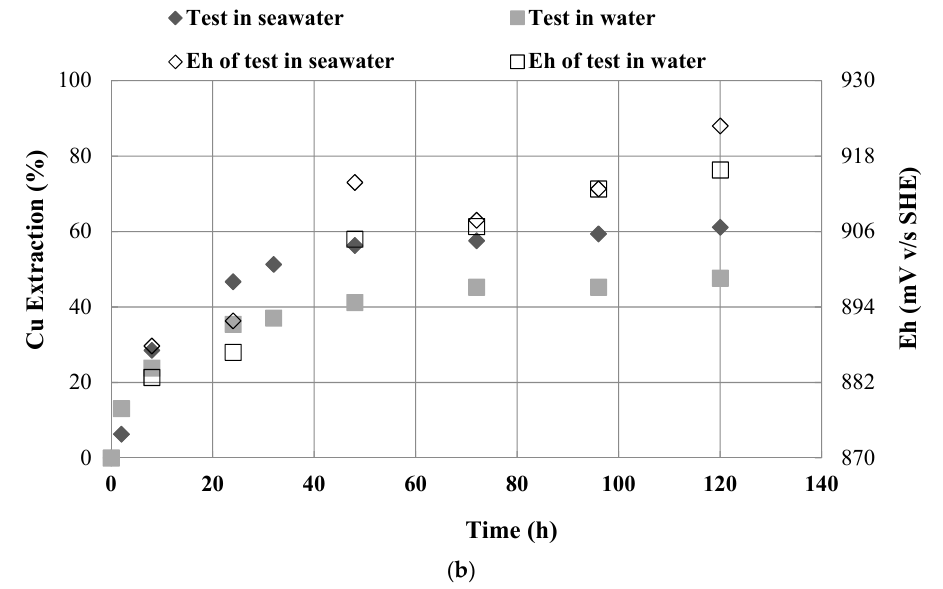
Figure 6. Values of redox potential (mV) against time (h) for the systems: ( a ) H 2 SO 4 (1 M), NaNO 3 (1 M) in seawater and water and ( b ) H 2 SO 4 (0.5 M), NaNO 3 (0.5 M) in seawater and water. Experimental conditions: 5 days of leaching and 45 °C.